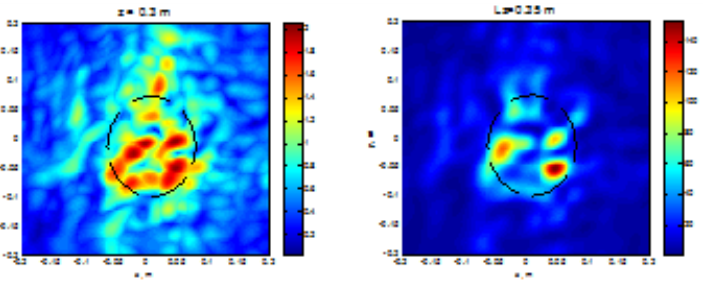
Figure 22. Aluminum ring with diameter of 18 cm in a subsurface medium at a depth of 12 cm.